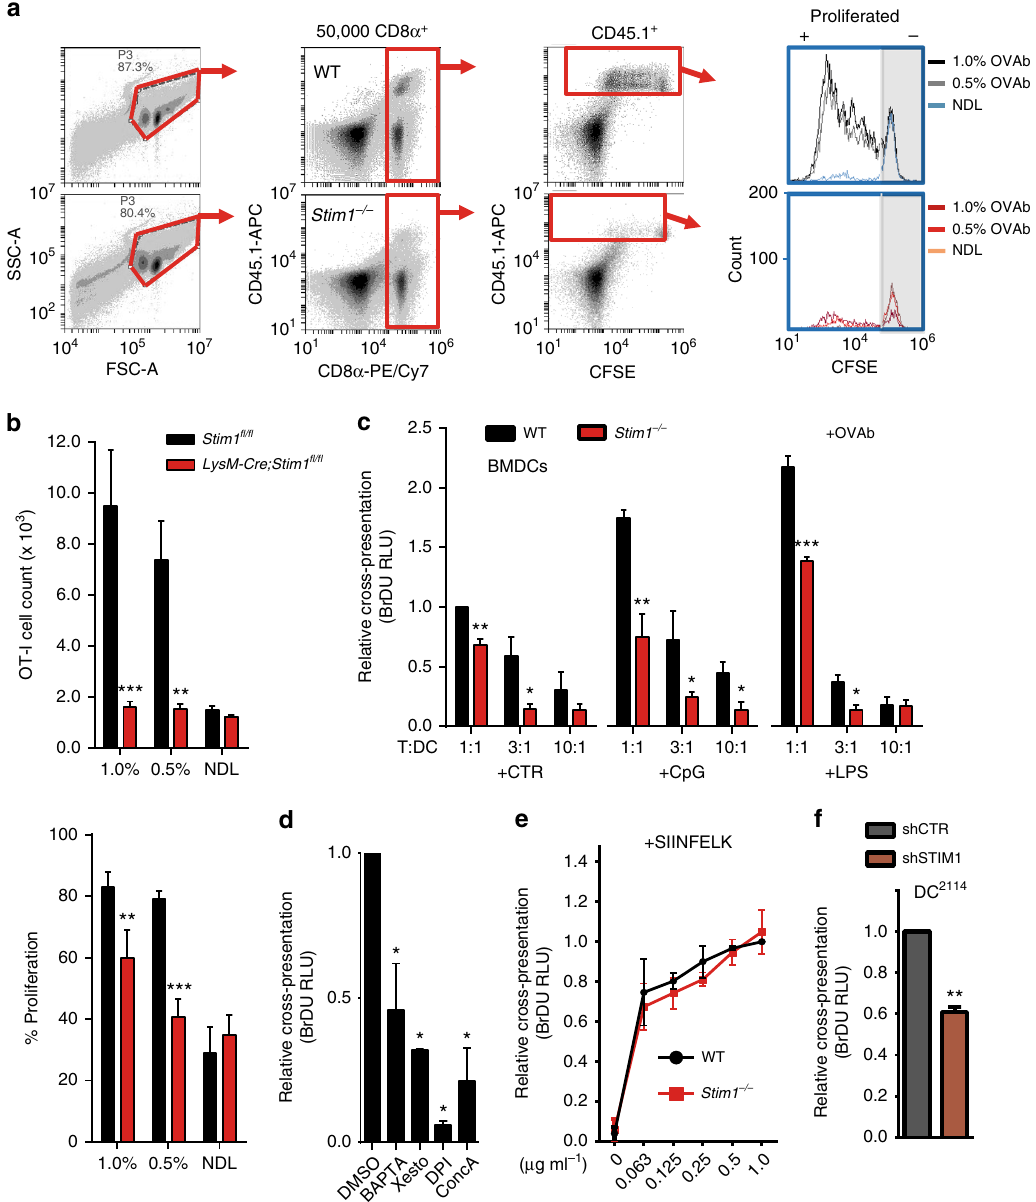
Fig. 1 STIM1 promotes cross-presentation in vivo and in vitro. a Representative fl ow cytometry gating strategy of cells isolated from draining (DL) and non-draining (NDL) lymph nodes of mice injected with 1.0 or 0.5% OVA-coated beads (OVAb), and with 1 × 10 6 CD45.1 + OT-I cells. Out of 50,000 CD8 α + cells, the total number of CD45.1 + OT-I cells and their corresponding CFSE fl uorescence were analysed. b OT-I cells were strongly decreased in DL but not NDL of CD45.2 + LysM-Cre; Stim1 fl / fl mice as compared to Stim1 fl / fl littermates (upper graph). Similarly, OT-I proliferation, as assessed by CFSE dilution, was signi fi cantly decreased in STIM1-de fi cient mice (lower graph). N = 3 pairs of mice. c Cross-presentation of OVA antigens to OT-I cells by BMDCs exposed to OVAb (4 h) was quanti fi ed as the BrDU incorporation after 72 h of co-culture. Stim1 ablation reduced cross-presentation in vitro, both in immature BMDCs and in cells matured with 1 μ g mL − 1 LPS or 0.1 μ M CpG, at varying OT-I:BMDC (T:DC) ratios. N = 3, in triplicate wells. Ratio 1:1 T:DC in unstimulated WT cells = 1. d Pre-incubation with 40 μ M BAPTA-AM or 1 μ M Xesto reduced cross-presentation, similar to known inhibitors 0.2 nM ConcA or 10 μ M DPI, applied as positive controls. N = 3, in triplicate wells. Control DMSO condition = 1. e Incubation with varying doses of the OVA(257 – 264) fragment SIINFEKL (1 h) induced similar levels of cross-presentation in WT and STIM1-de fi cient BMDCs. N = 3, in triplicate wells. f Reduced cross- presentation was also observed in DC 2114 + shSTIM1, as compared to control (+shCTR) as assessed with BrDU. Phagocytic targets added at 20:1 targets: cells. N = 3, in triplicate wells. Error bars are means ± SEM, p * < 0.5, ** p < 0.1, *** p < 0.01 using a two-way ANOVA and Sidak ’ s post test for b , c and e ,